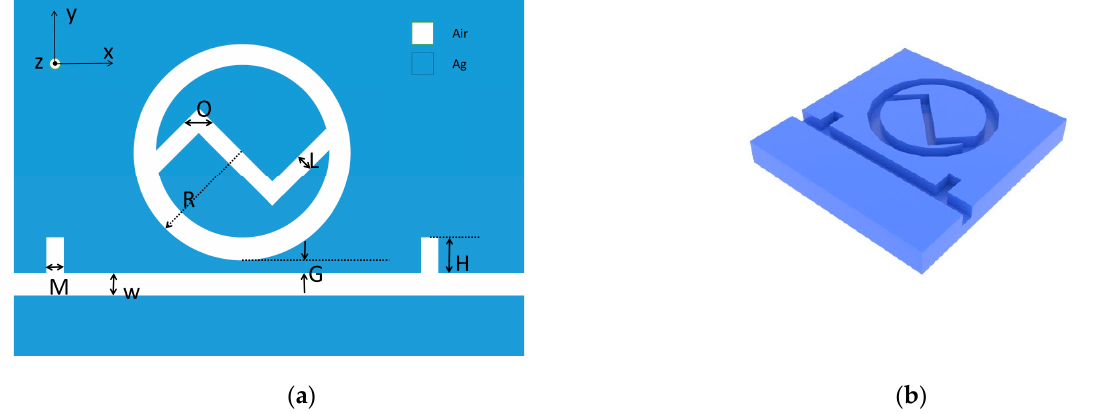
Figure 1. ( a ) Two-dimensional diagram of the IZRR structure. ( b ) Three-dimensional diagram of the IZRR structure.